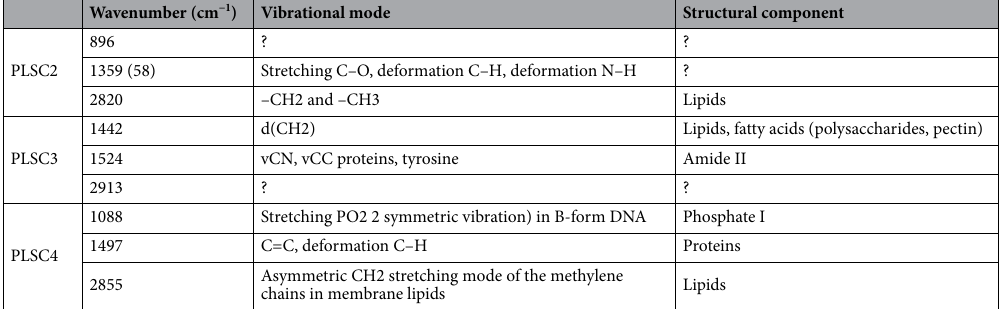
2855 Asymmetric CH2 stretching mode of the methylene chains in membrane lipids Table 2. Main vibrational modes present in the fingerprint region between 650–1800 cm −1 and the high wavenumber region between 2800–3000 cm −1 of the PLS loading spectra of PLSC2, PLSC3 and PLSC4 for the analysis of the LIQUID 1 dataset (according to Movasaghi et al. 21 and Naseer et al. 22 ).